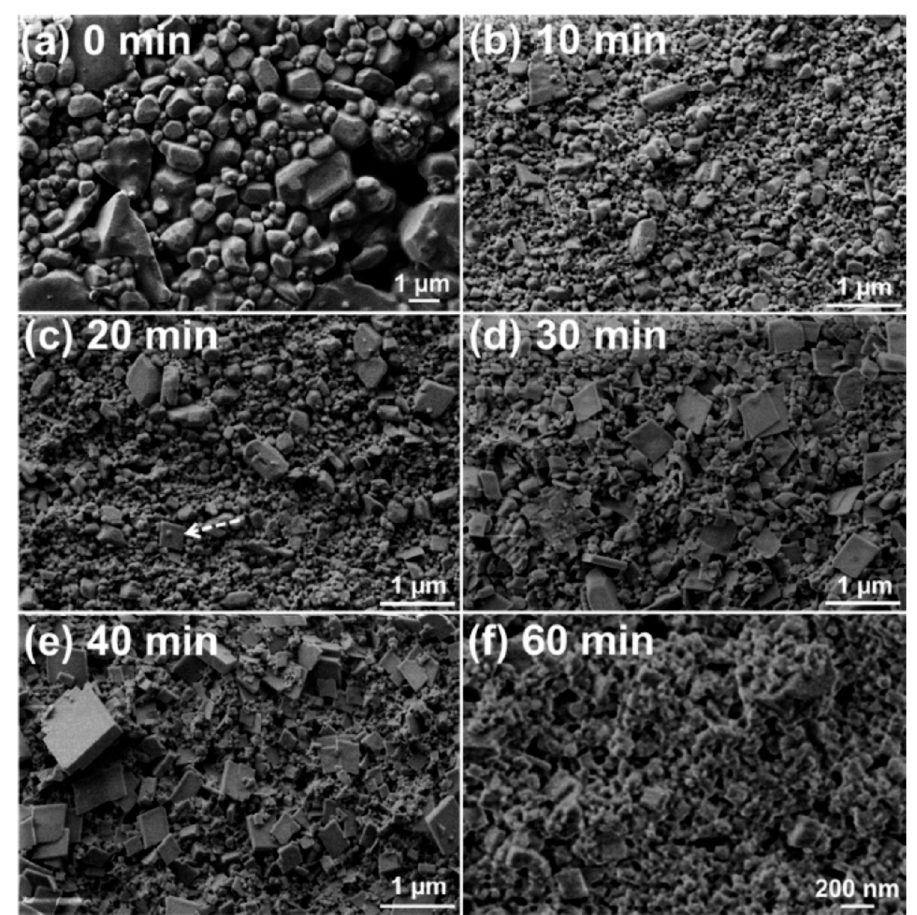
Figure 12. SEM images ( a – f ) of specimens sampled at milling times between 0 and 60 min. [36], with permission from Cryst. Eng. Comm,